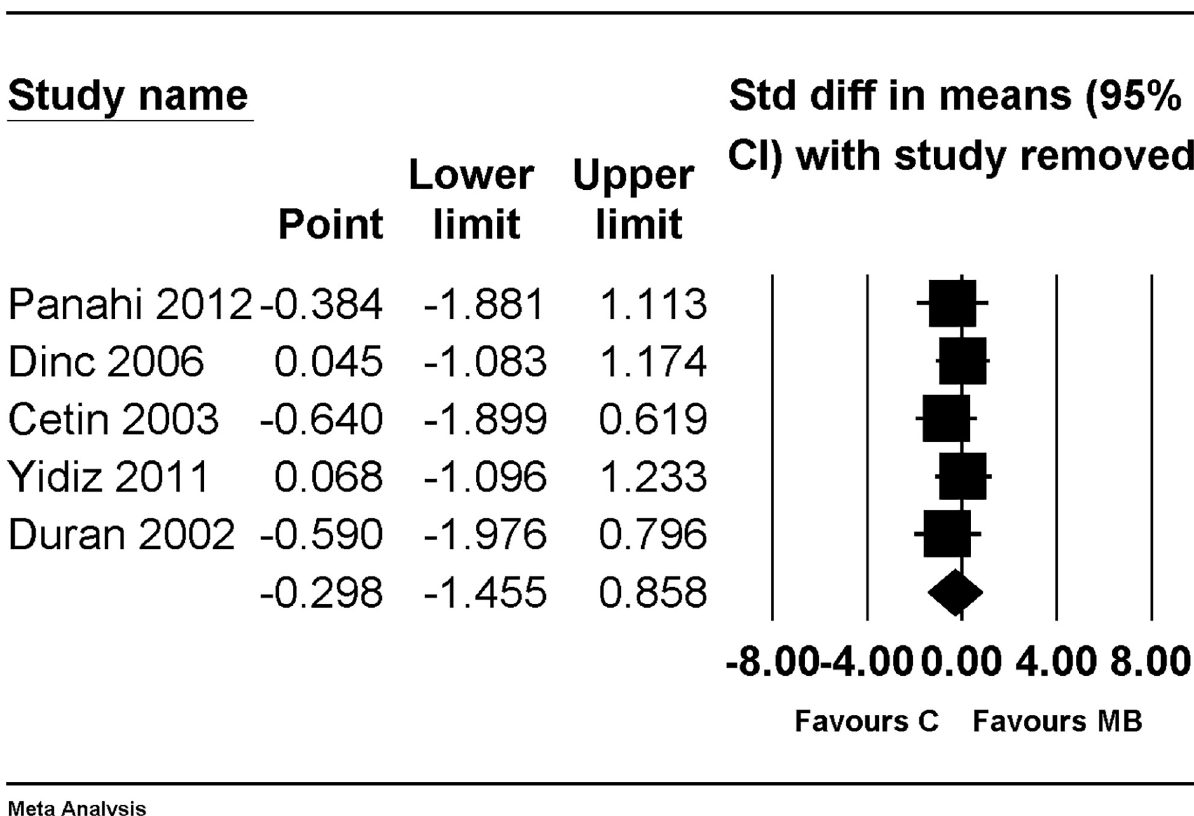
Fig 7. Forest plot showing sensitivity analysis performed by removing one study at a time for an overall effect of macroscopic adhesion score, compared with results of using nothing as control. The figure depicts individual trials as filled squares with relative sample size and the 95% confidence interval (CI) of the difference as a solid line. The diamond shape indicates the pooled estimate and uncertainty for the combined effect.